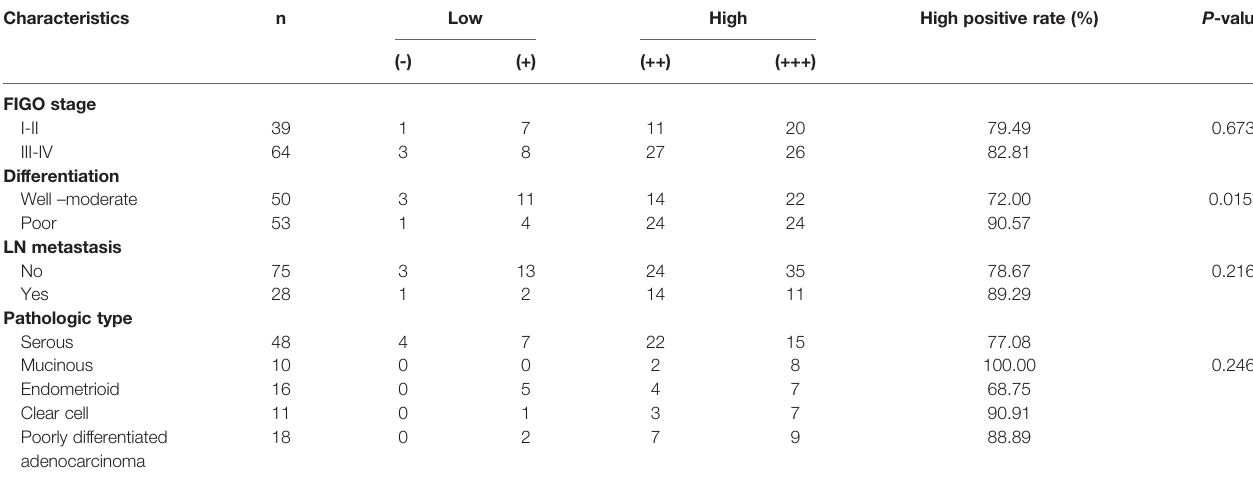
TABLE 1 | Relationships between PGK1 expression in epithelial ovarian cancer and clinicopathological parameters.